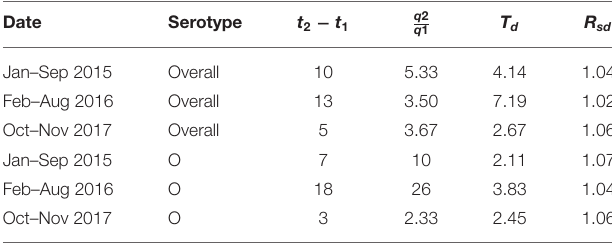
sd ) for FMD outbreaks by serotype in cattle in northern Thailand between 2015 and